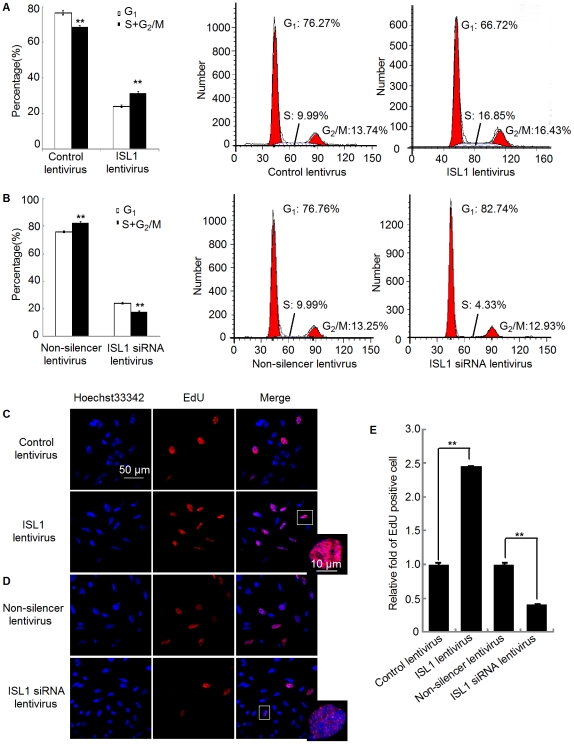
ISL1 promoted proliferation of adult pancreatic cells.Adult pancreatic islet cells infected with ISL1 lentivirus (A) or ISL1-siRNA lentivirus (B) were subjected to cell cycle analysis by flow cytometry. The data represent 3 independent experiments. The representative cytometric results from these experiments are shown. EdU incorporation assay was analyzed by confocal microscopy (scale bar, 50 µm; scale bar in magnified field, 10 µm) in adult islets infected with ISL1 lentivirus (C) or ISL1-siRNA lentivirus (D). (E) The EdU incorporation rate was expressed as the ratio of EdU positive cells to total Hoechst33342 positive cells. Each bar represents mean ± SD from 3 samples (**p<0.01, vs. the control).